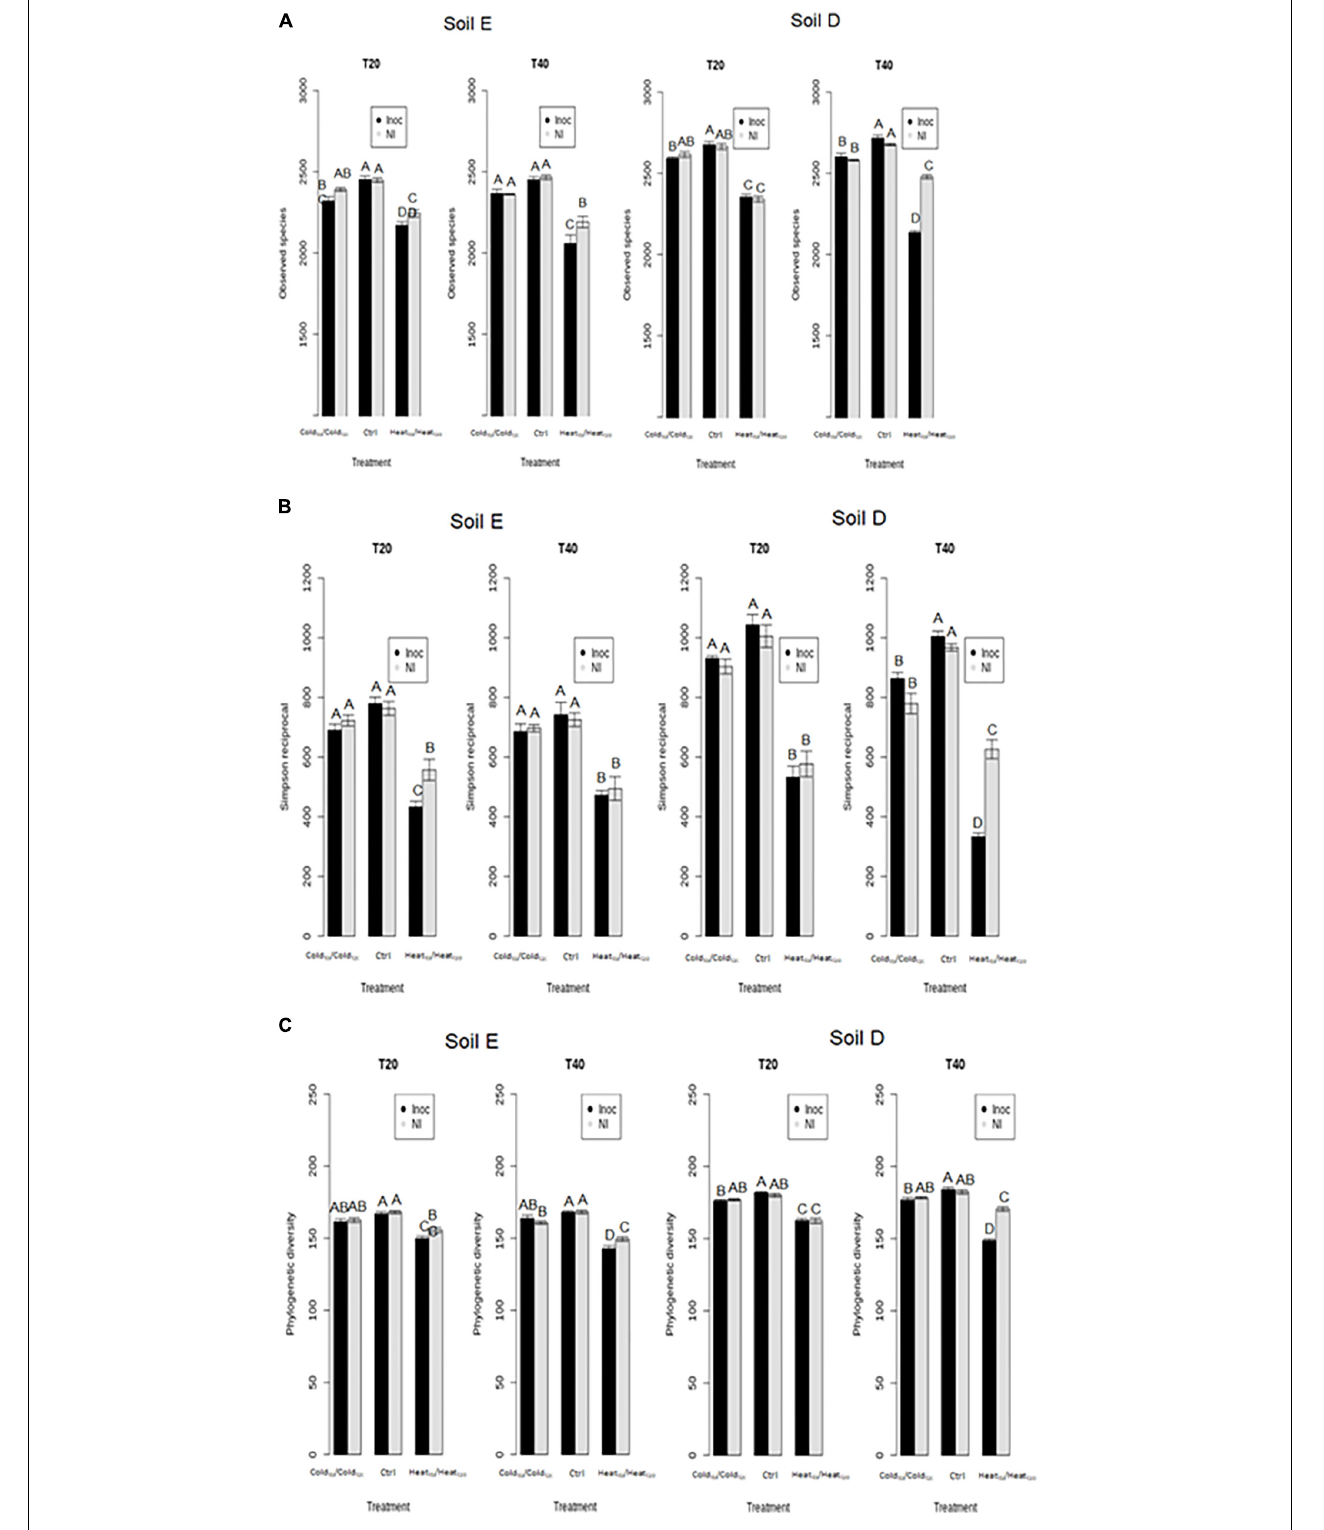
FIGURE 5 | Assessment of the effect of the invasive species on bacterial diversity components of soil E and soil D microcosms facing different disturbance sequences. (A) Richness estimated by the observed species index. (B) Evenness estimated by Simpson’s reciprocal index. (C) Phylogenetic diversity estimated by Faith’s phylogenetic diversity index. Letters above the bars indicate significance of the differences according to Tukey’s test ( P < 0.05).